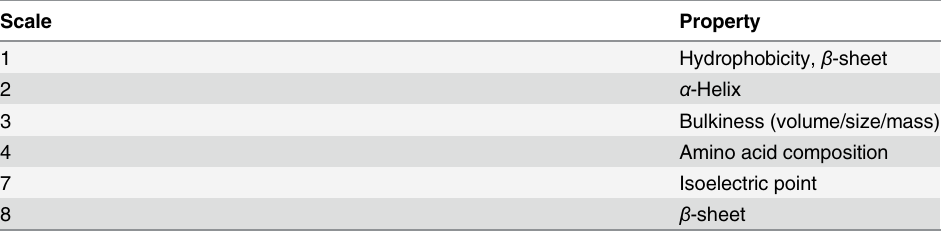
Table 2. The amino acid scales that corresponds the best to physicochemical